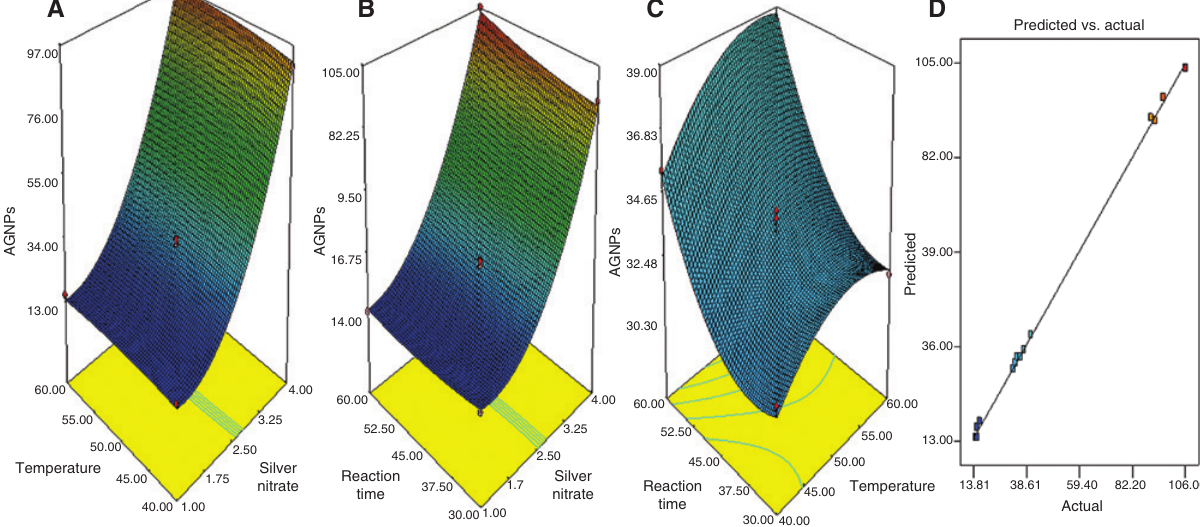
Figure 2: (A–C) Response surface plots showing combined effects of silver nitrate concentration, temperature, and reaction time on size of AgNPs and (D) predicted vs. actual plot